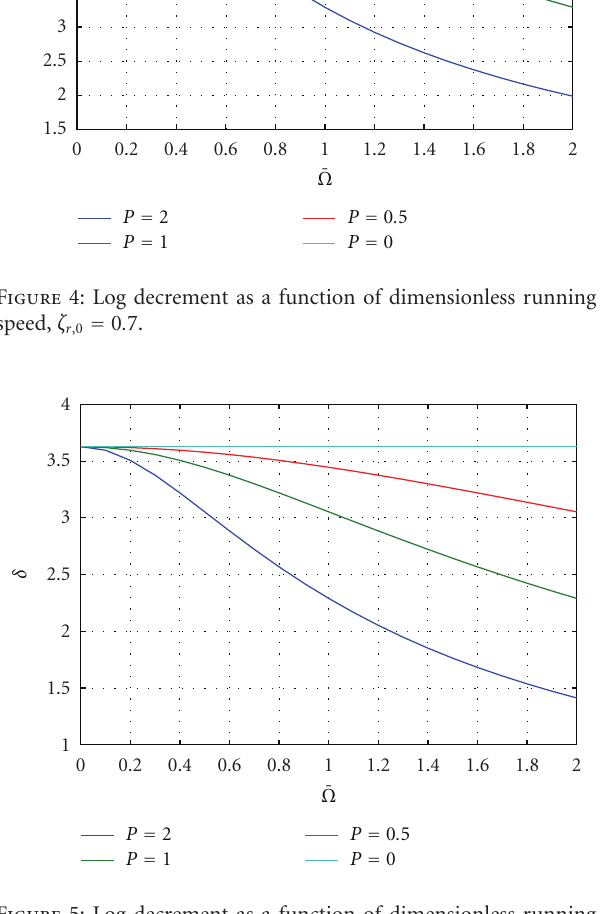
Figure 5: Log decrement as a function of dimensionless running speed, ζ r ,0 = 0 . 5.